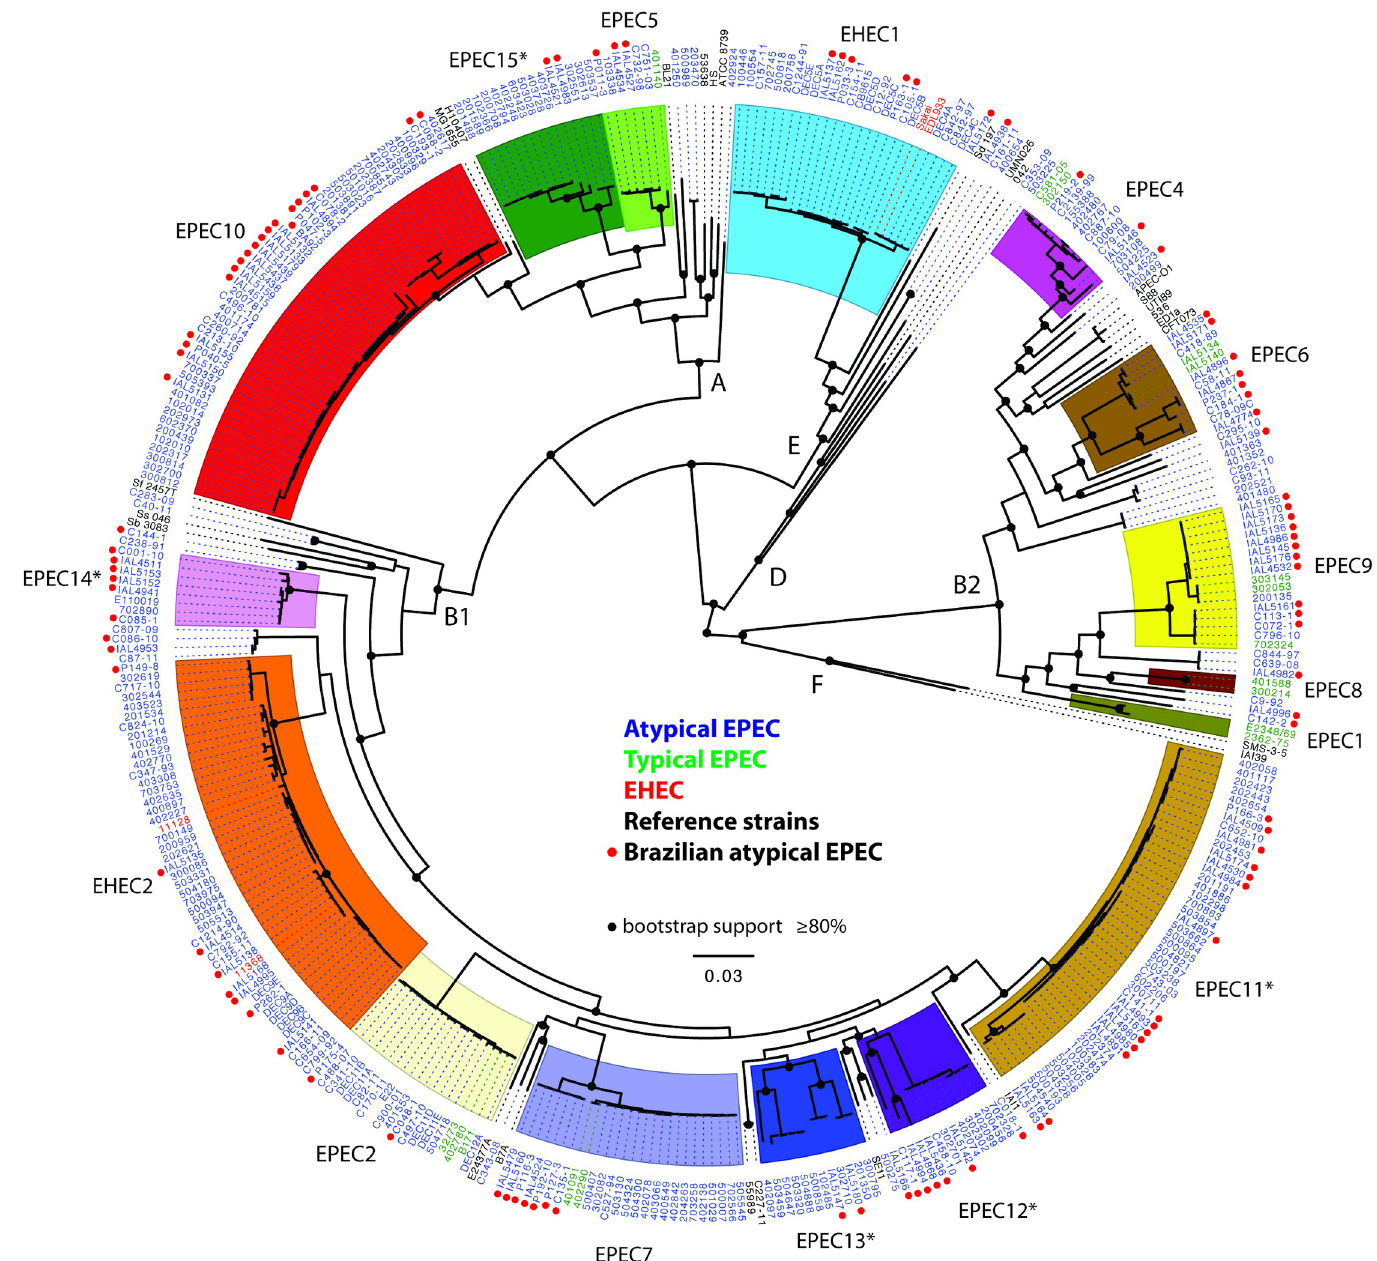
Fig 1. Phylogenomic analysis of aEPEC from Brazil compared to aEPEC from other geographic origins. Phylogenomic analysis of atypical EPEC genomes (labeled in blue), compared to typical EPEC (labeled in green), EHEC (labeled in red) and reference E . coli and Shigella genomes (labeled in black). Red circles indicate the 106 Brazilian aEPEC genomes. The clades in the phylogeny are colored by phylogenomic lineage, and the E . coli phylogroups are indicated by the letters: A, B1, B2, D, E, and F. An asterisk ( � ) indicates the five novel EPEC phylogenomic lineages identified in this study. The nodes with bootstrap values > 80% are labeled with a black circle.